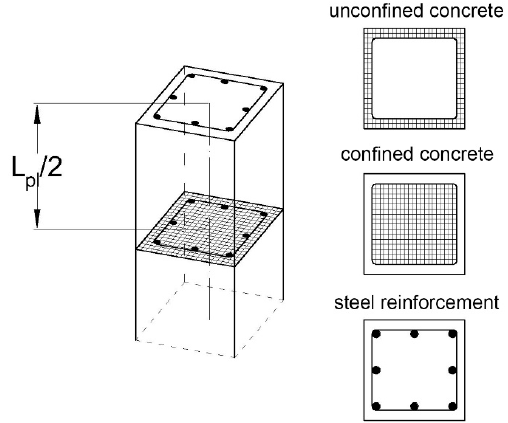
Figure 7. Schematic presentation of plastic hinge on a column element with appropriate section parts and names of the used materials.